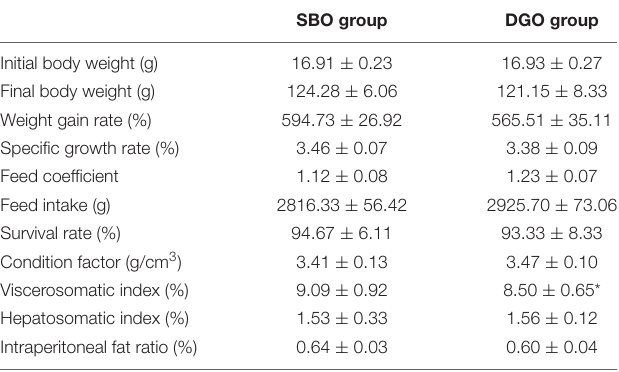
TABLE 4 | Effects of DAG-enriched oil on growth performance, feed coefficient, and organ indices in fish.